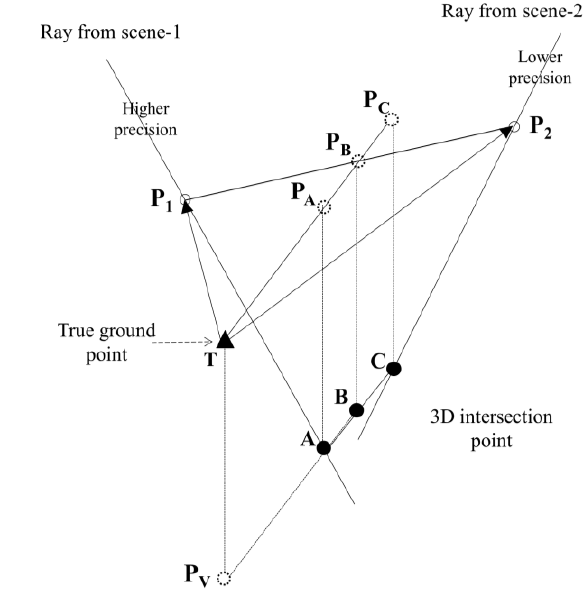
Figure 10. Dependence of the horizontal error on the intersection-finding method employed.